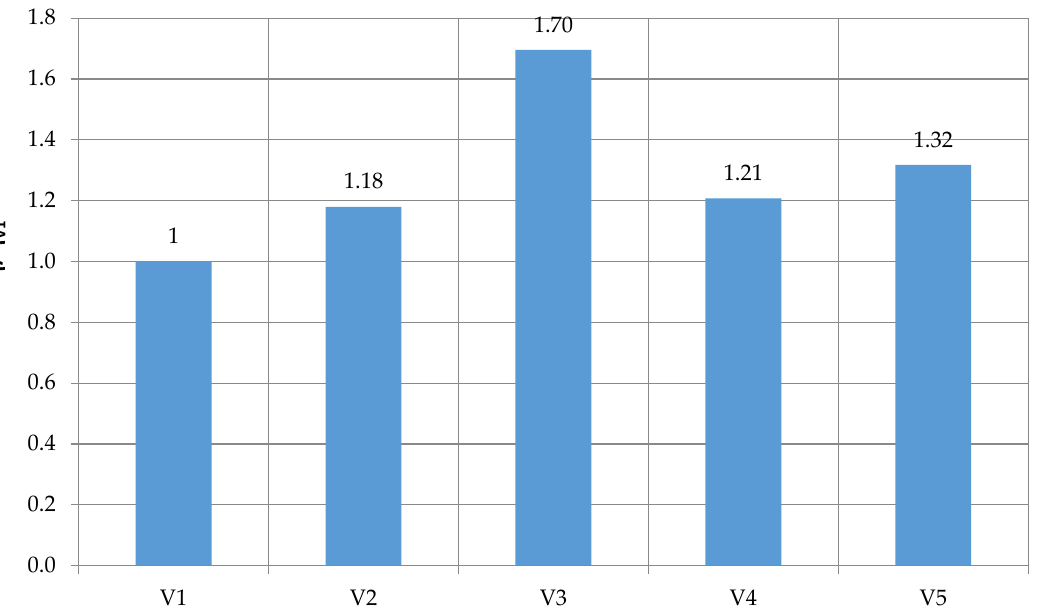
Figure 7. The effect of the cycle structure on its efficiency as compared to variant 1 for heating value W d = 24.4 MJ/kg.